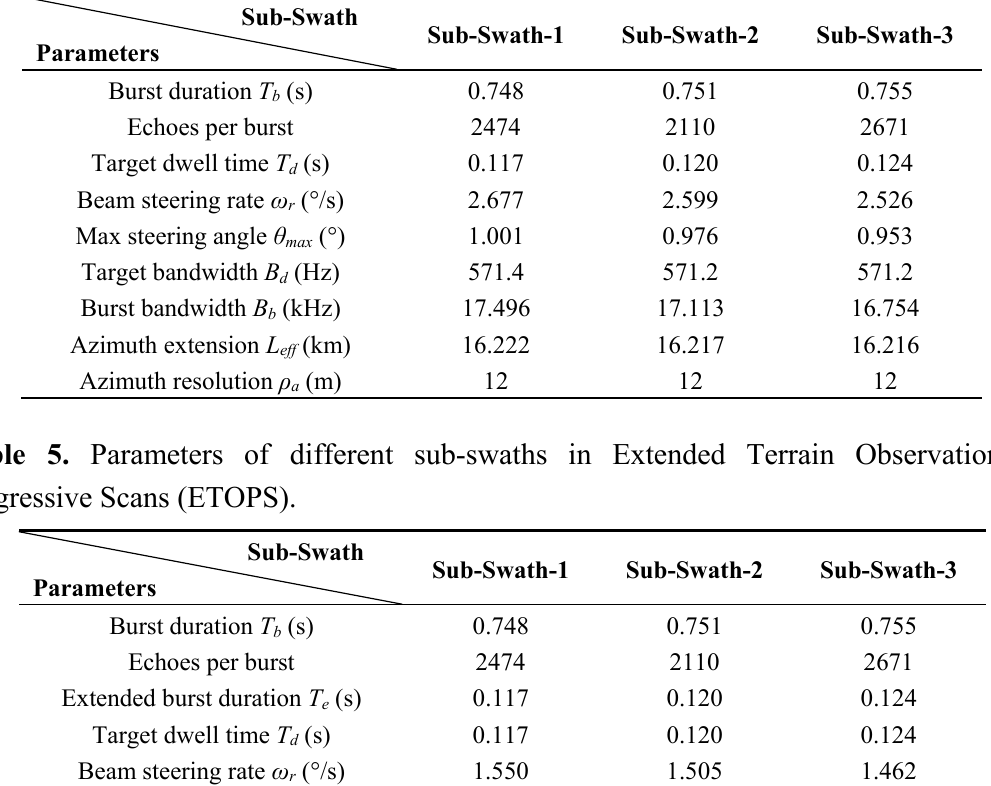
Table 4. Parameters of different sub-swaths in inverse TOPS (ITOPS).